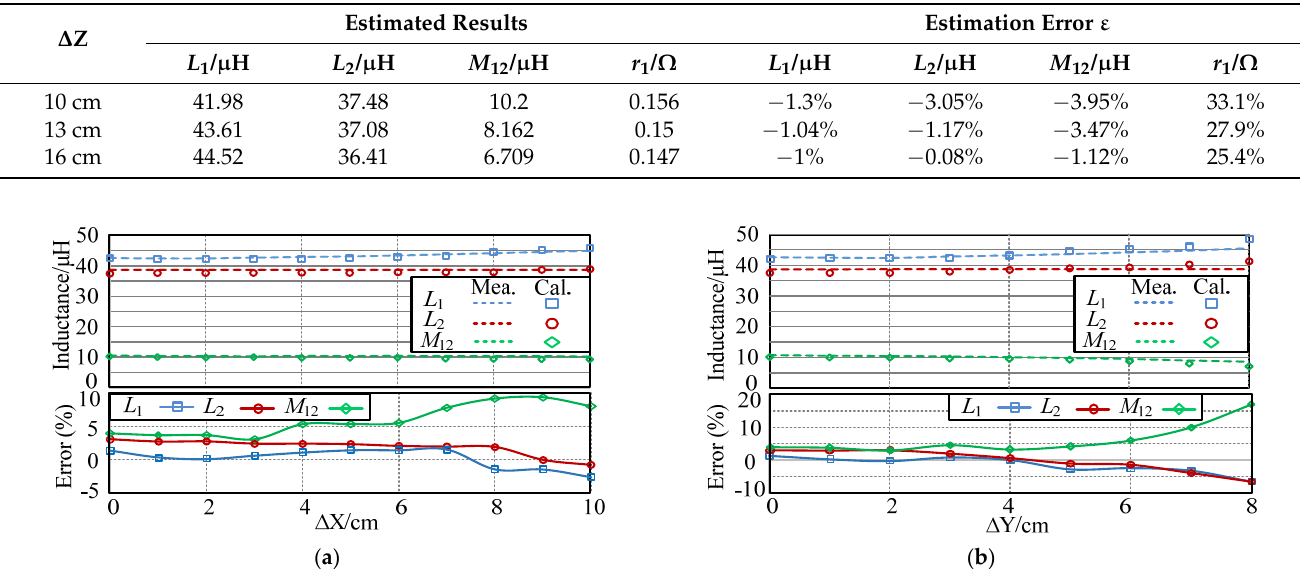
Figure 14. Experimental results for the off-line estimation versus ( a ) ∆ X; ( b ) ∆ Y.